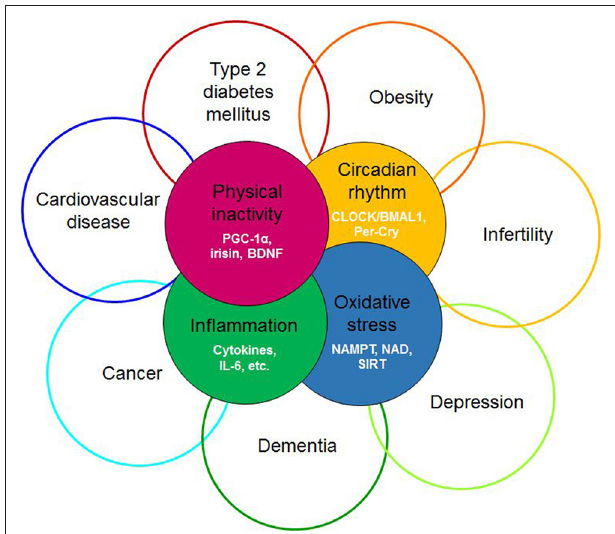
FIGURE 1 | Redefining the diseasome of physician inactivity: evolution of the cluster of diseases defined by the diseasome of physical inactivity due to the derangement of complex interactions between the circadian, the redox, the inflammatory and the muscle derived irisin/BDNF axis. BDNF, brain-derived neurotrophic factor; PGC-1 α , peroxisome proliferator-activated receptor γ coactivator 1 α ; CLOCK, Circadian Locomotor Output Cycles Kaput; BMAL1, brain and muscle ARNT-like protein 1; Per-Cry, period and cryptochrome; IL-6, interleukin 6; NAMPT, nicotinamide phosphoribosyltransferase; NAD, nicotinamide adenine dinucleotide; SIRT1, sirtuin